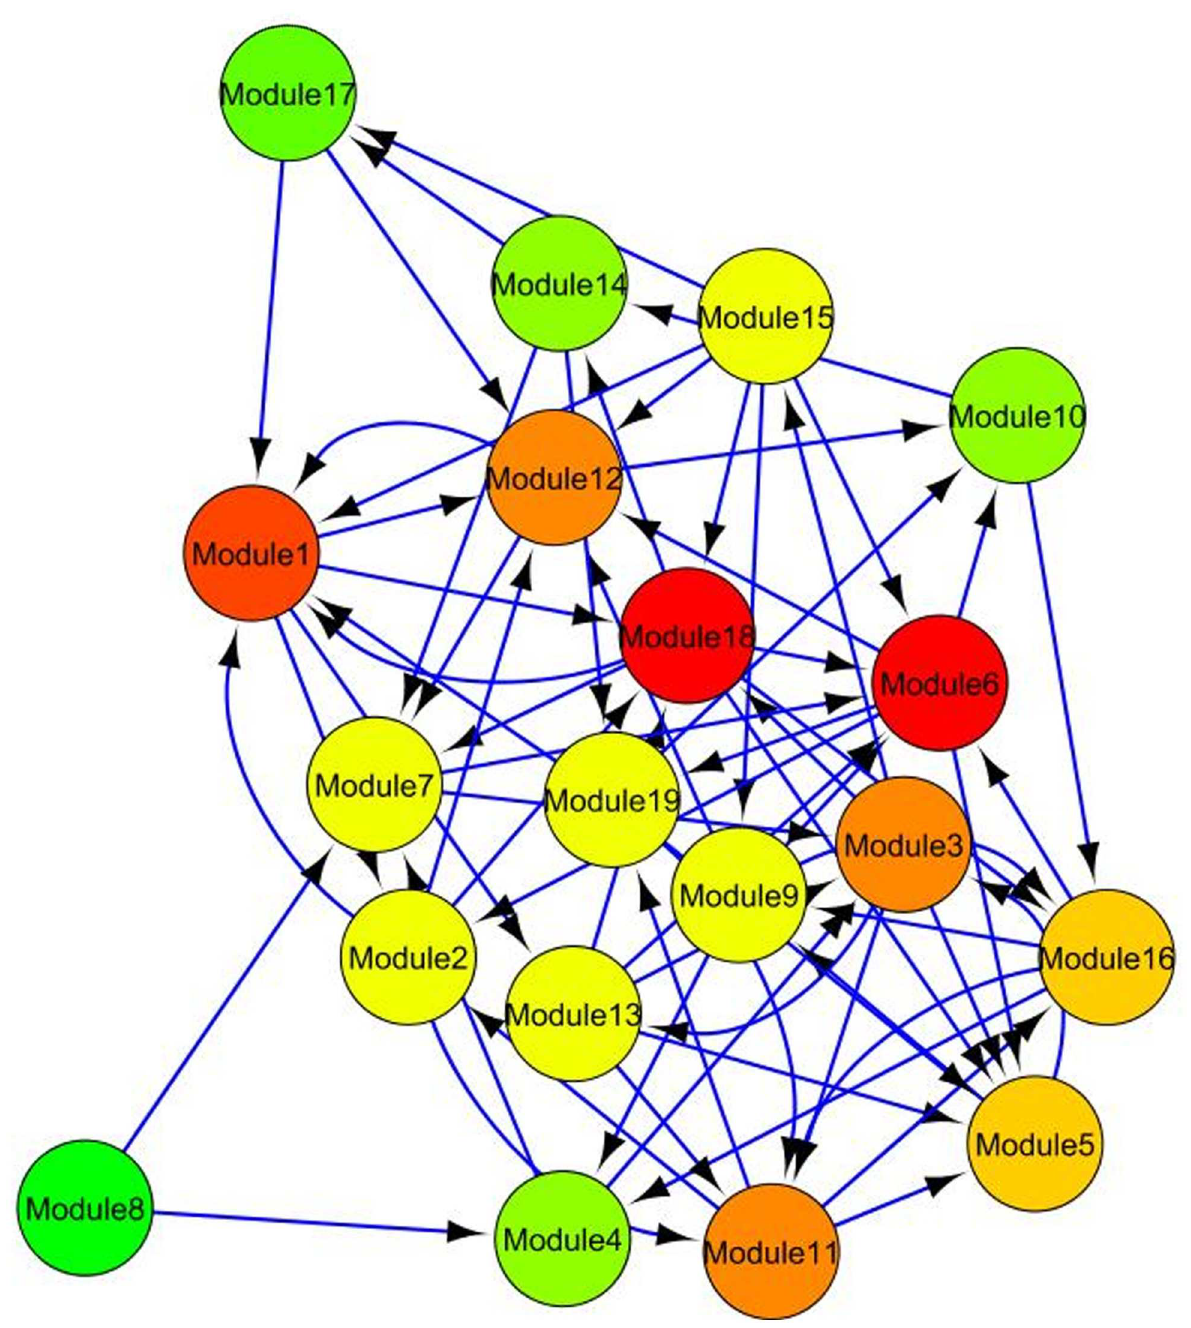
Fig 4. Module interaction network for gene modules under Al stress. The network consists of 19 nodesand 70 edges(regulatory relations). To remove the weak interactionamongthe modules,a threshold value for posterior probabilityis fixed at 0.2.